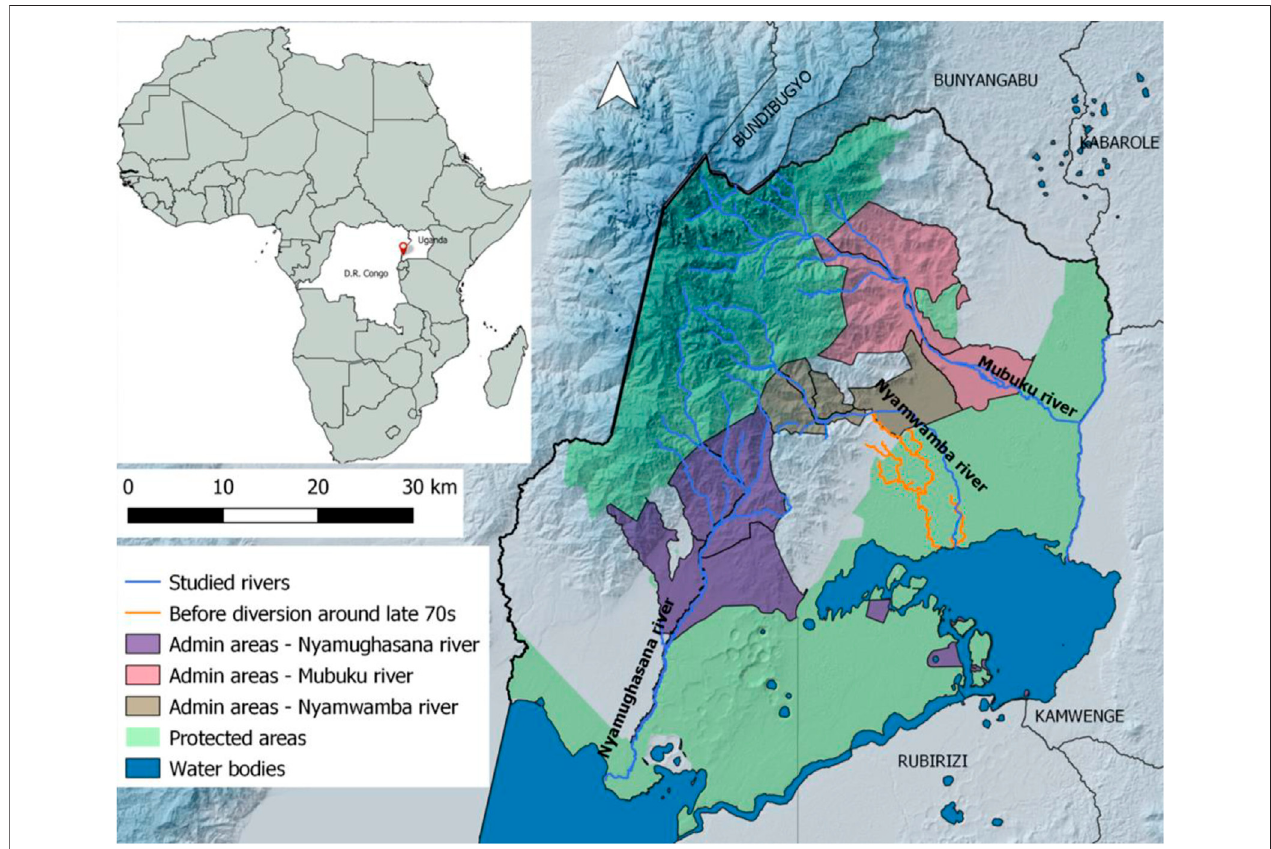
FIGURE 2 | Study area and characteristics in Kasese district, southwestern Rwenzori region. All highlighted are sub-county level administrative areas.